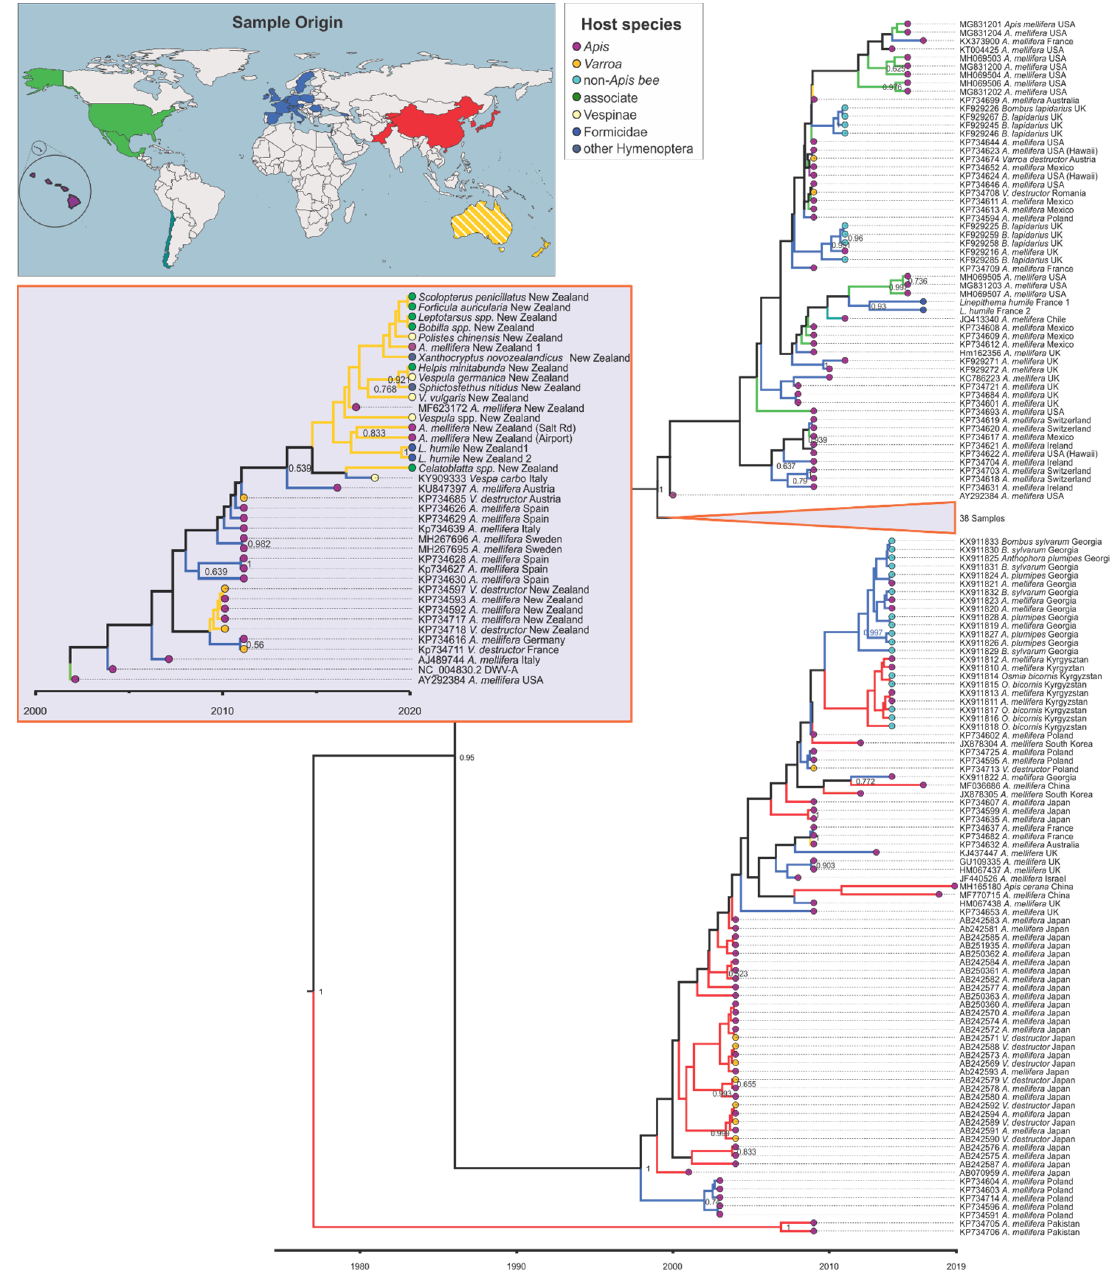
Figure 2. Maximum clade credibility tree for the RNA-dependent RNA polymerase ( RdRp ) fragment (440 bp) of deformed wing virus (DWV). Grey insert with orange frame shows the collapsed part of the tree that among others includes the 19 samples from New Zealand from this study. Species name, country of origin, and, if applicable, GenBank accession number are given in the branch label. The branches are coloured according to the lineages’ inferred geographic origin as shown on the world map and end notes are coloured according to the host group as shown in the host species insert. Posterior support > 0.6 is given and the x-axis shows time in years.